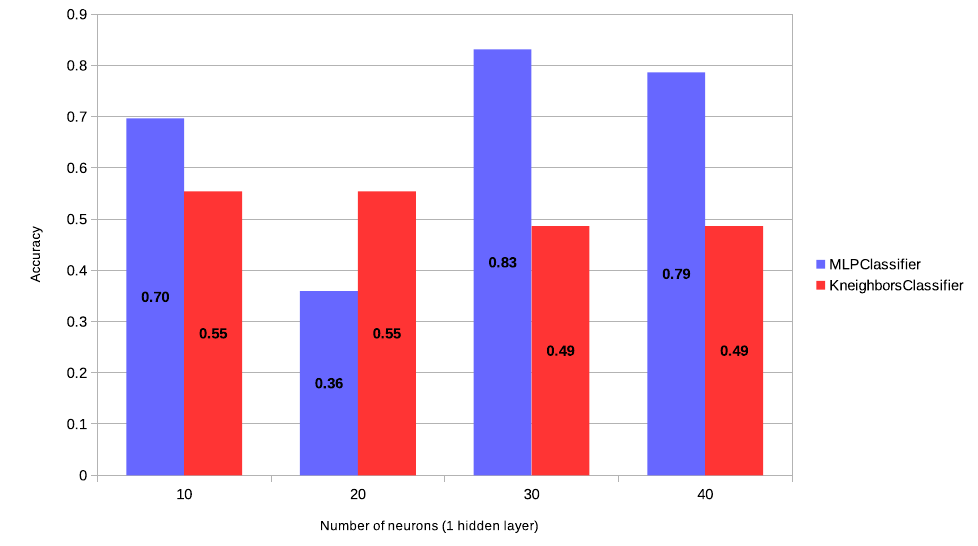
Figure 12. Classification model for dual method—testing different classification